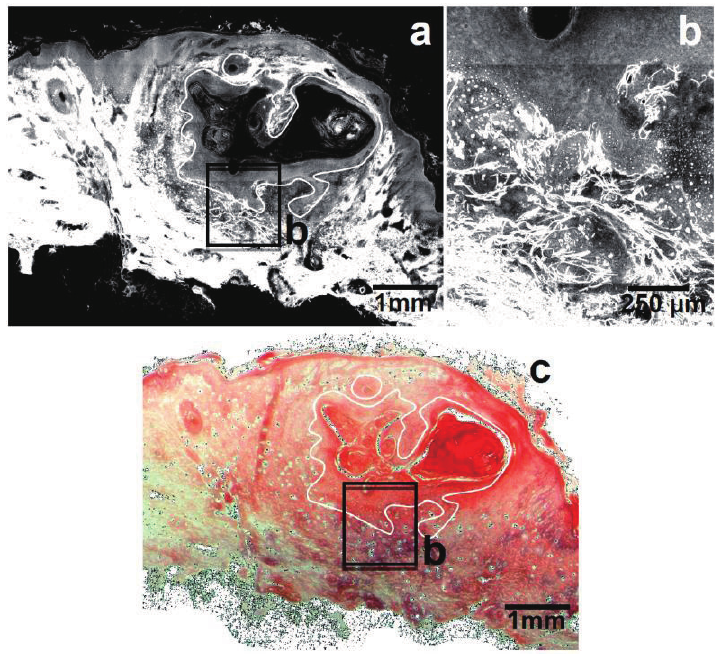
Figure A2. TPEF images of a SCC. ( a ) Overview scan of a SCC. The white curve illustrates the tumor border; ( b ) Tumorous tissue adjacent to non-tumorous tissue. The elastin fibers appearing brightest in TPEF are located exclusively in the non-tumorous area; ( c ) H&E stained section with marked tumorous